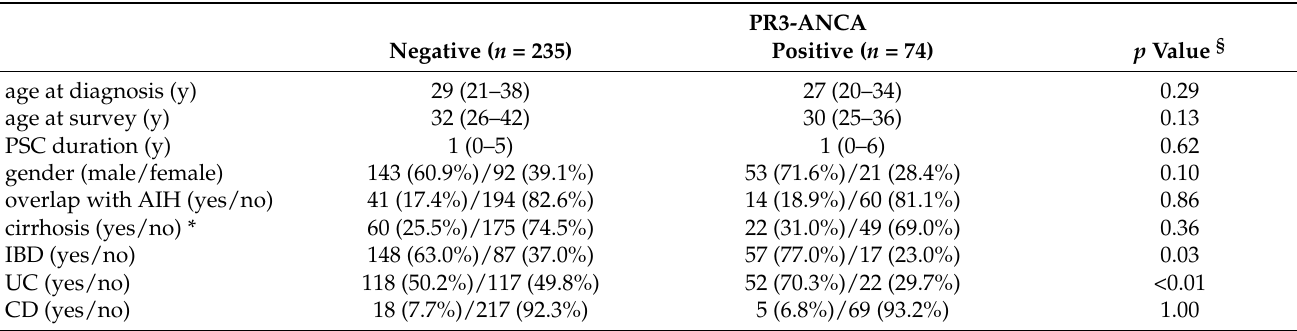
Table 3. Association of PR3-ANCA positivity with characteristics of 309 patients with primary sclerosing cholangitis. Abbreviations: autoimmune hepatitis, AIH; inflammatory bowel disease, IBD; Crohn’s disease, CD; ulcerative colitis, UC; years, y.